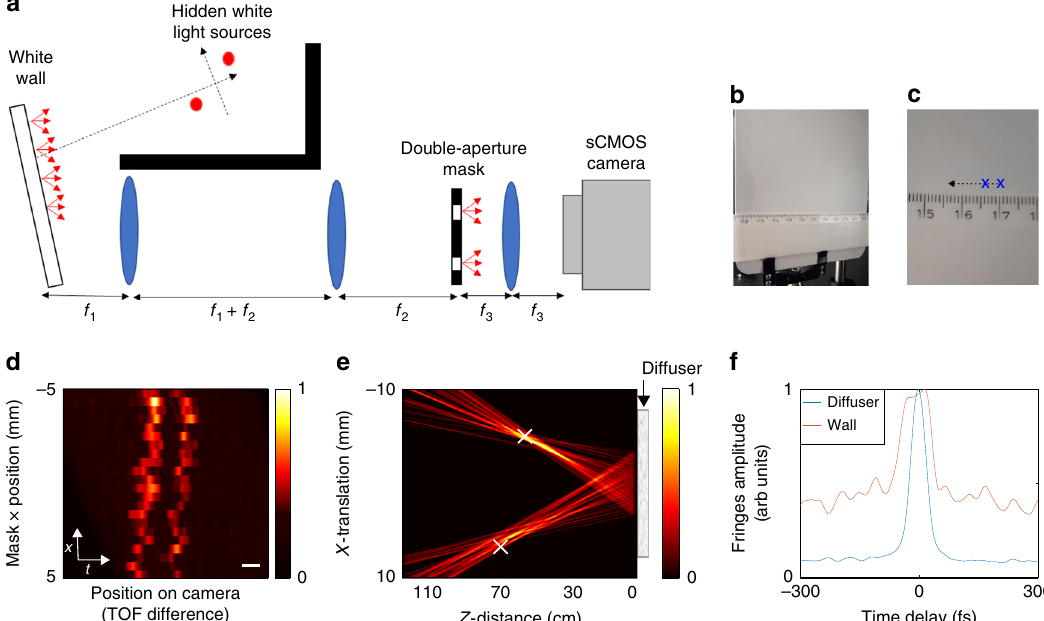
Fig. 4 Localizing multiple light sources around a corner. a Setup (top view): hidden white light sources illuminate a white-painted surface. The wall surface is imaged by a 4-f telescope on a movable double-aperture mask. The light from the two apertures is interfered on the camera by a lens. b , c Photographs of the wall surface. The imaged apertures positions are marked by ‘ x ’ . The mask scan trajectory is depicted by a dashed line. d Interference fringes envelope as a function of the double-aperture mask position, revealing the two hidden sources. e Scene reconstructed from ( d ) by back-projection. The sources real positions are marked by ‘ x ’ . f fringes envelope as a function of the time delay, for the case of a thin diffuser (blue), and the white-painted barrier (orange).